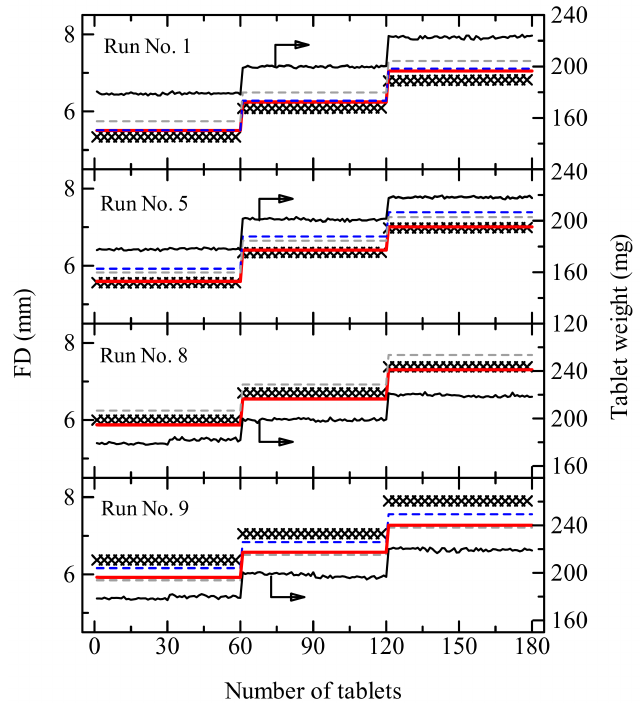
Figure 3. Actual setting ( × ) and predicted values of FD for the desired tablet weights of 180, 200, and 220 mg by the NIR model (gray dashed line), physical attribute model (blue dashed line), and combination model (red solid line). The solid back line indicates the actual weight of tablets. The prediction was performed for batches of the four runs (No. 1, 5, 8, and 9) shown in Table